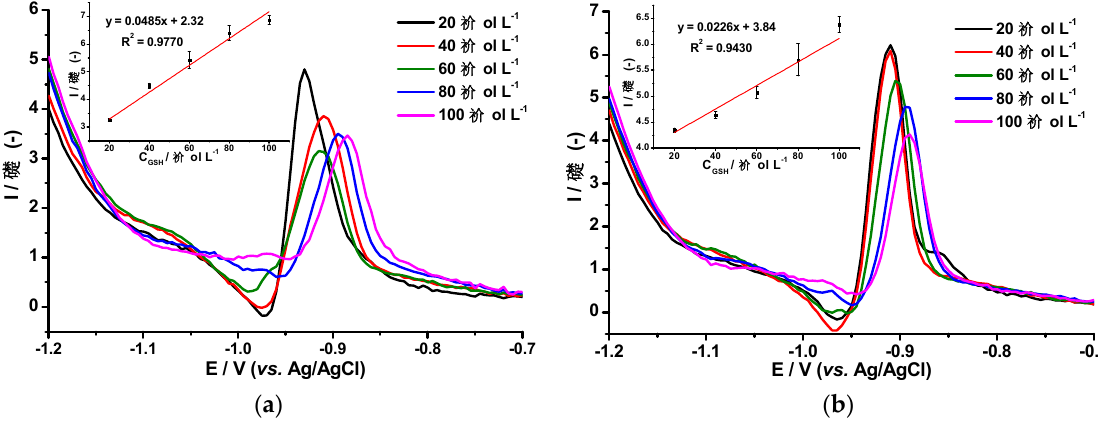
Figure 6. VPD responses of ( a ) AgHgNf/Cu electrode and ( b ) AgBiNf/Cu electrode in a Brdi č ka supporting electrolyte after addition of 20 to 100 µmol L − 1 of Glutathione (GSH). Inset: Calibration curves of GSH using the AgHgNf/Cu and the AgBiNf/Cu electrodes. 25 mV s − 1 scan rate.